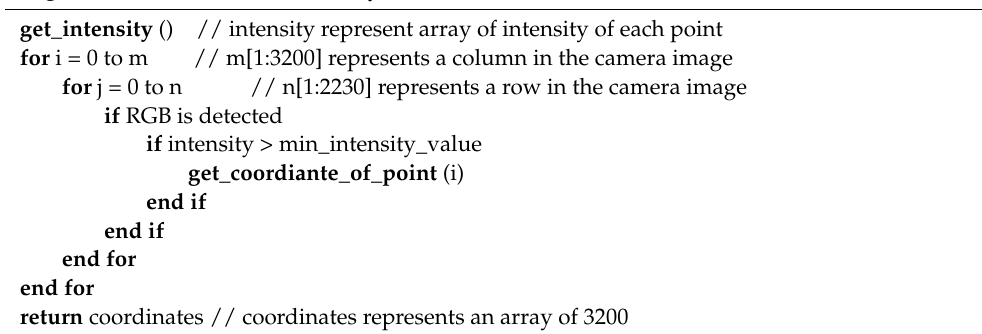
Algorithm 2. Laser line detection by CCD vision sensor.